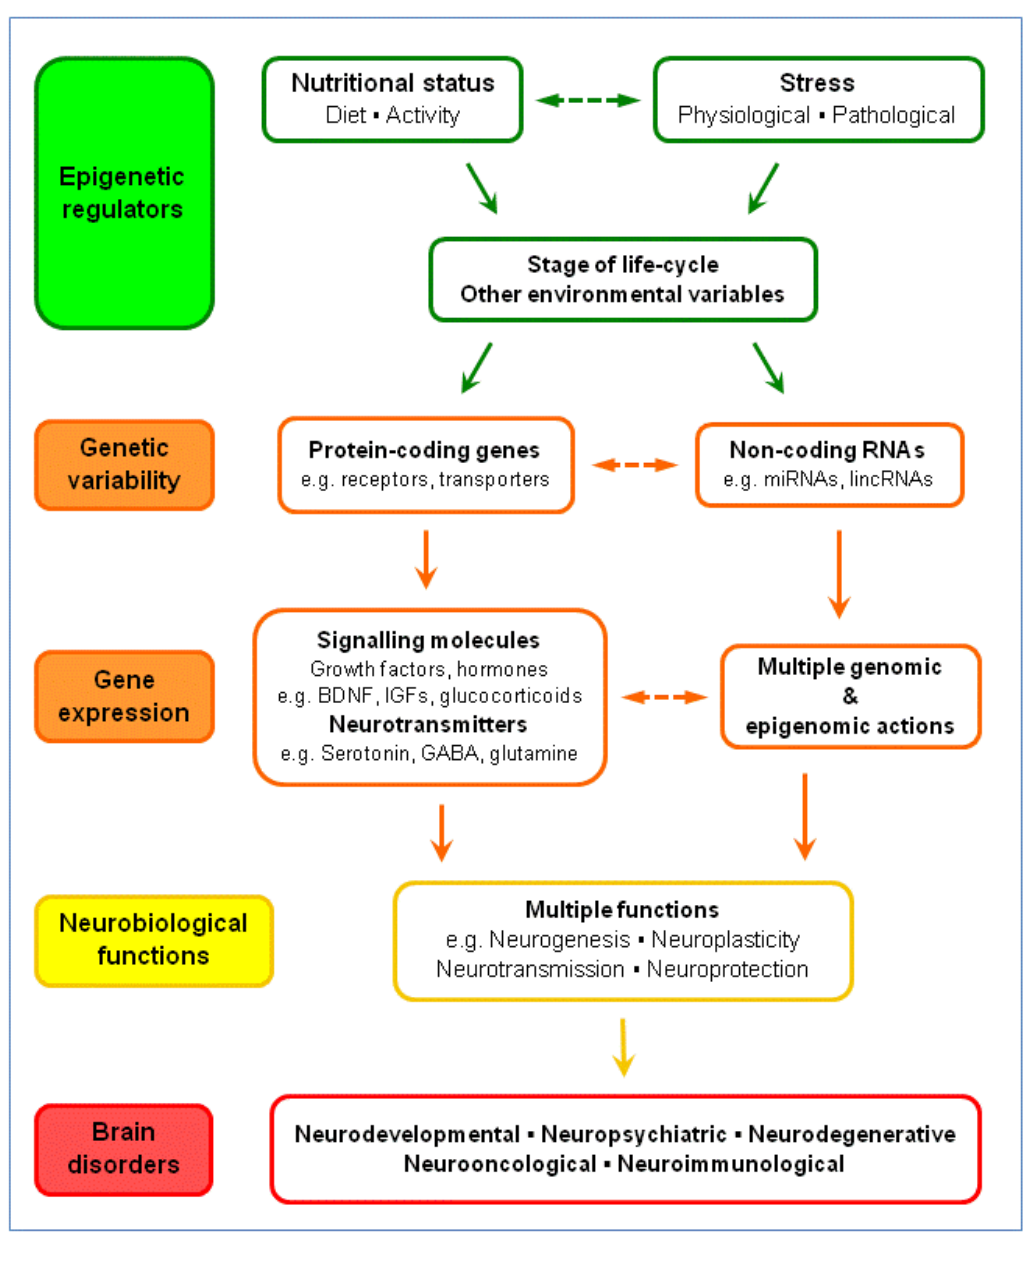
Figure 4. Nutrition-stress-gene interactions and brain